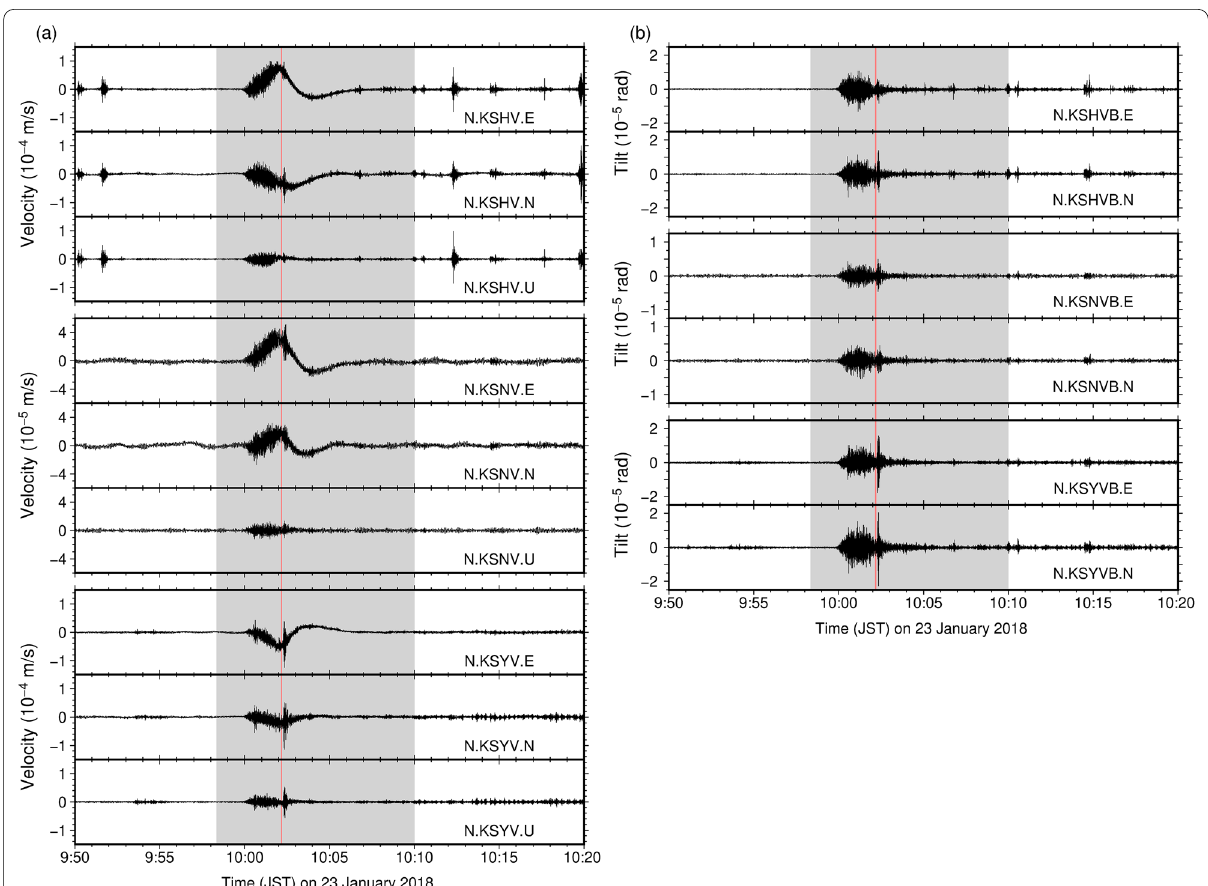
Fig. 3 Recorded waveforms. a Velocity waveforms recorded by broadband seismometers and b tilt waveforms recorded by tiltmeters around the eruption onset time. The red line shows the eruption onset time (10:02:09 Japan Standard Time (JST)) at Mount Motoshirane. The gray band represents the time window used in this study (09:58:20–10:10:00